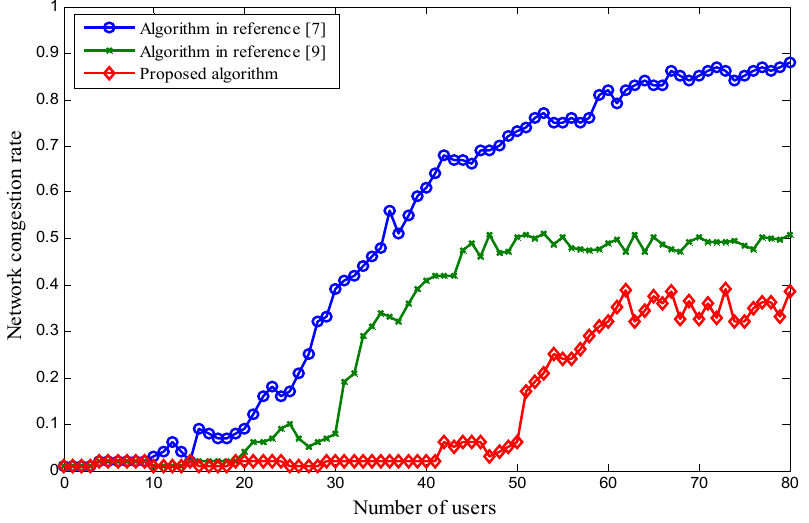
Figure 7. The integrated network congestion rate with larger wireless network bandwidth.